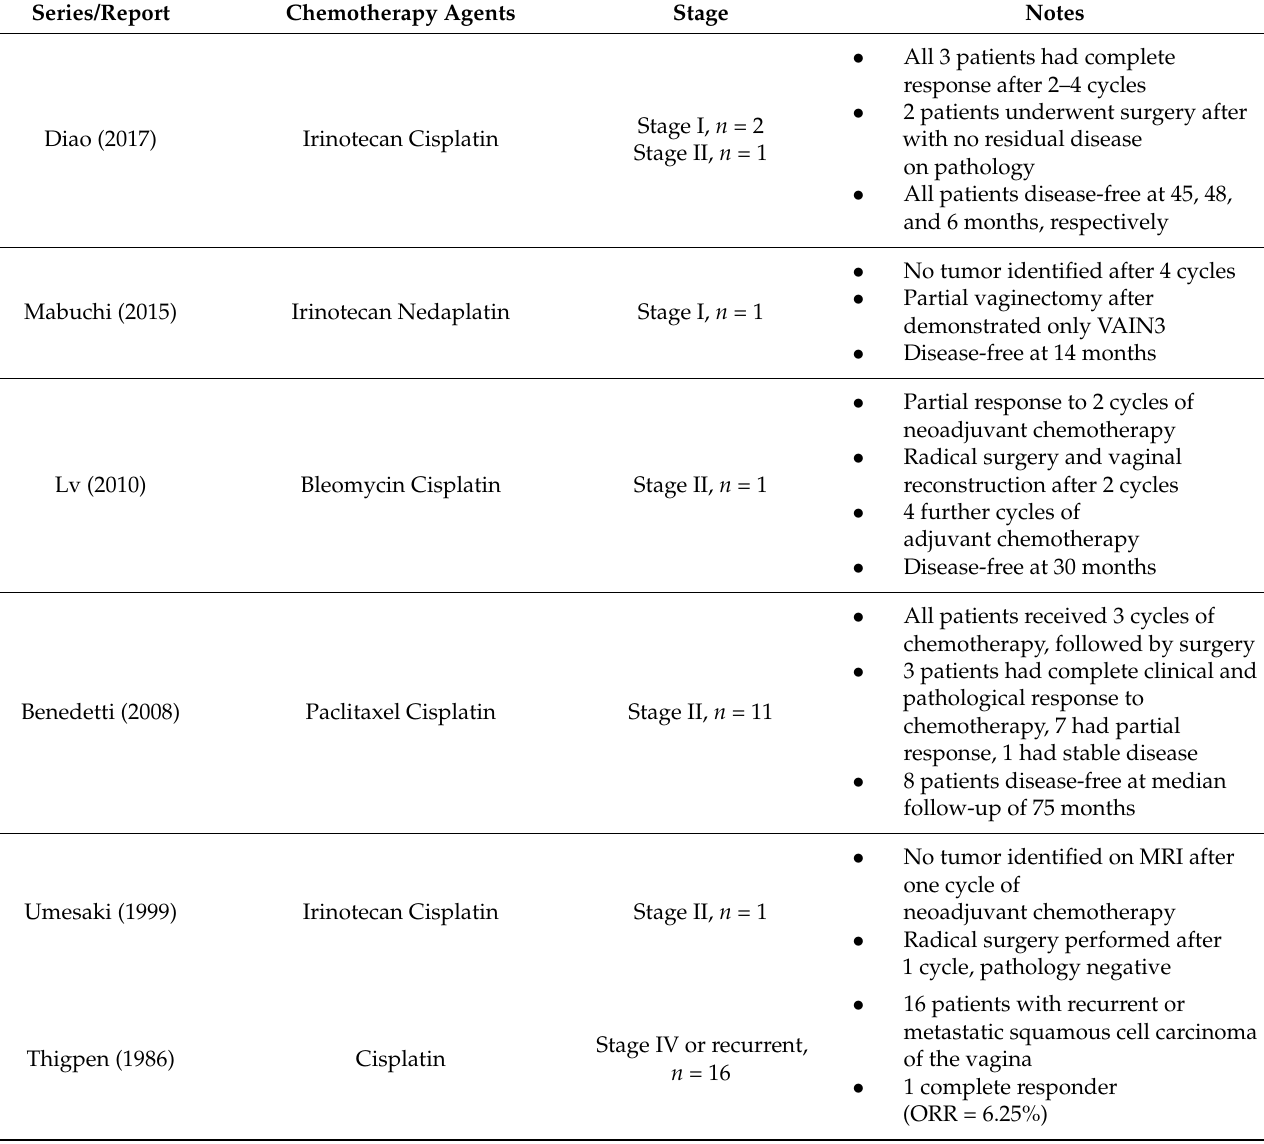
Table 1. Case series and case reports for systemic chemotherapy for treatment of vaginal